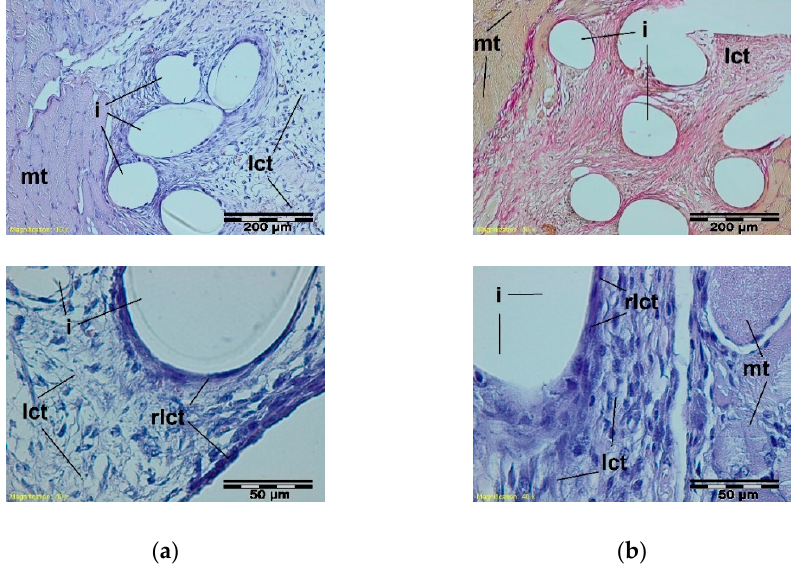
Figure 6. A microscopic view of the PACVD-modified sample ( a ) and the reference ( b ) 1 week after the intramuscular implantation. The monofilaments of knitted fabrics (i) surrounded by a loose connective tissue (lct) are separated from the muscle tissue (mt). A rich-in-cell, loose connective tissue (rlct) in the immediate vicinity of the monofilaments of the knitted structure is visible. Magnification 100×, Stain. HE and VG; Magnification 400×, Stain. HE.